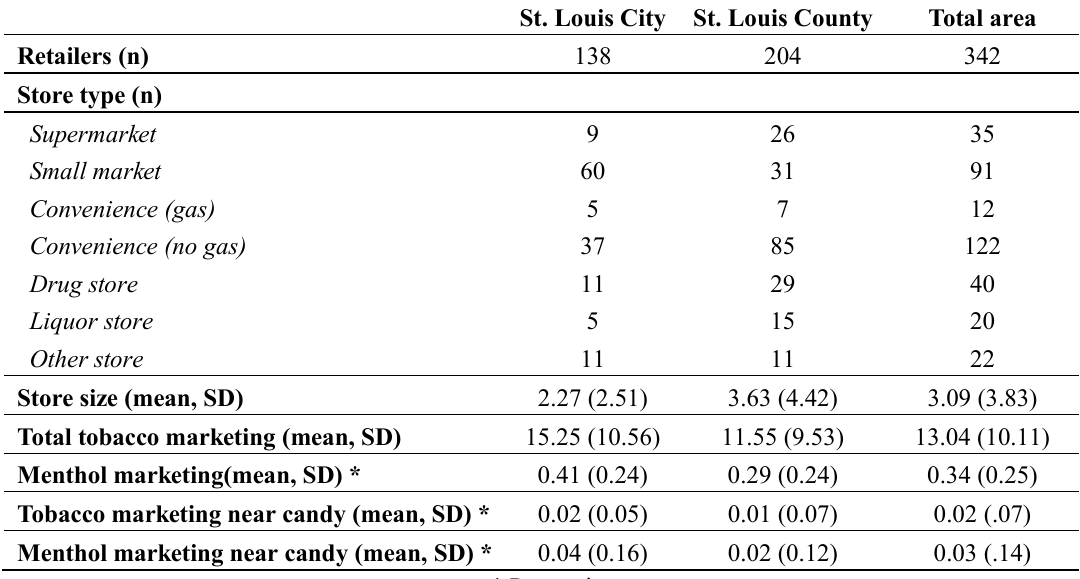
Table 2. Tobacco marketing characteristics in St. Louis tobacco retailers